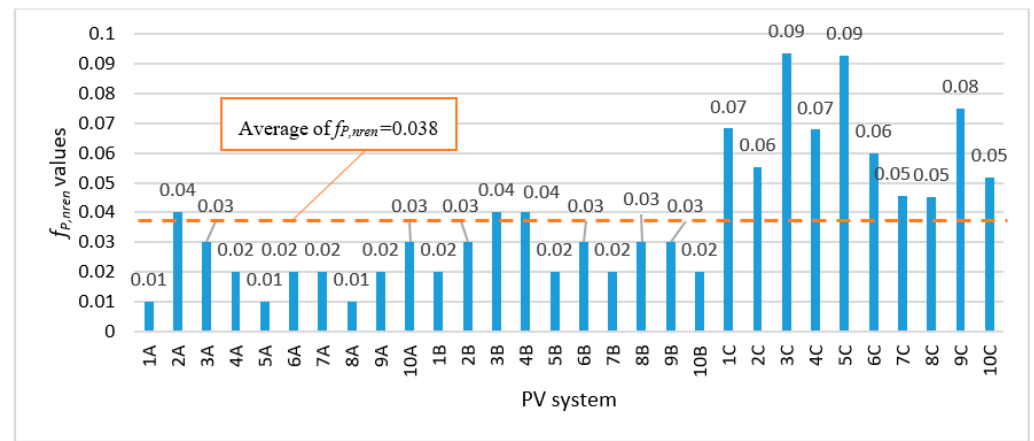
Figure 1. Relationship between f Pnren and PV power in PV systems.